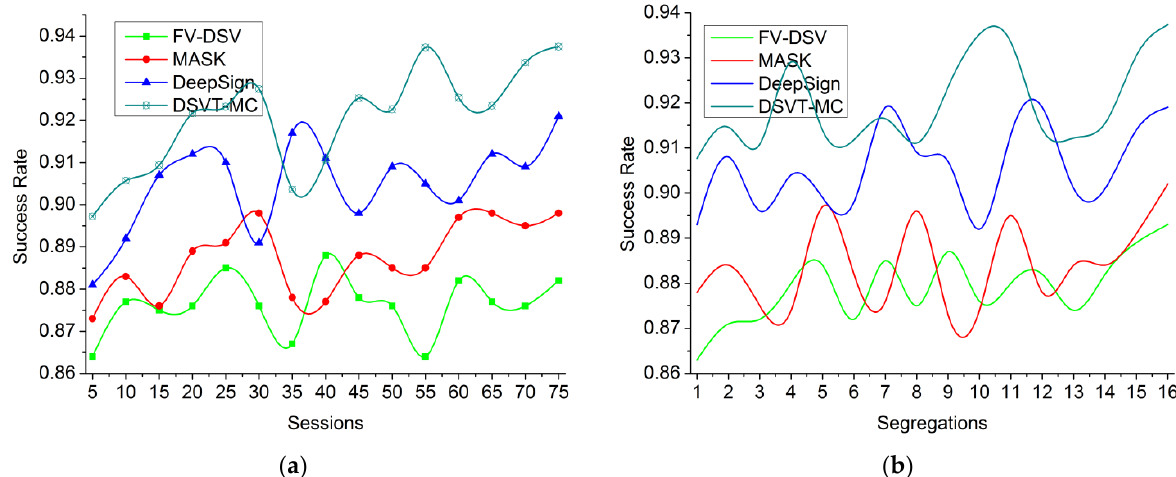
Figure 10. Authentication Success Rate for ( a ) different session rate ( b ) Segregation.